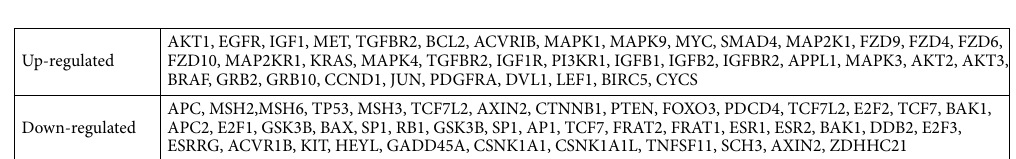
Table 2. The predicted candidate genes in rectal cancer patients.